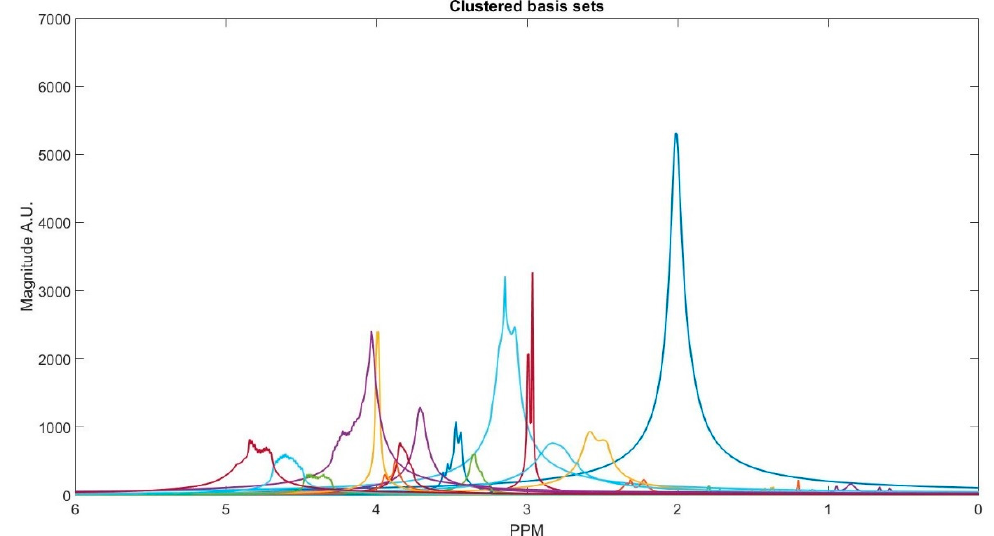
Figure 3. Spectrum of the in vivo data FID signal components clustered into basis sets of the metabolites.